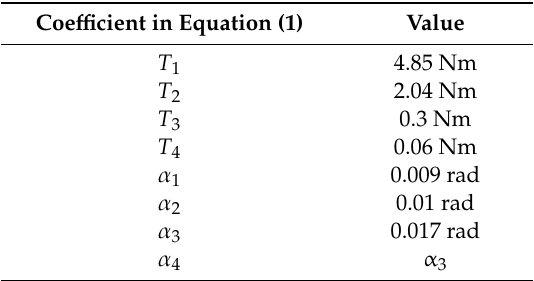
Table 1. Cogging torque model